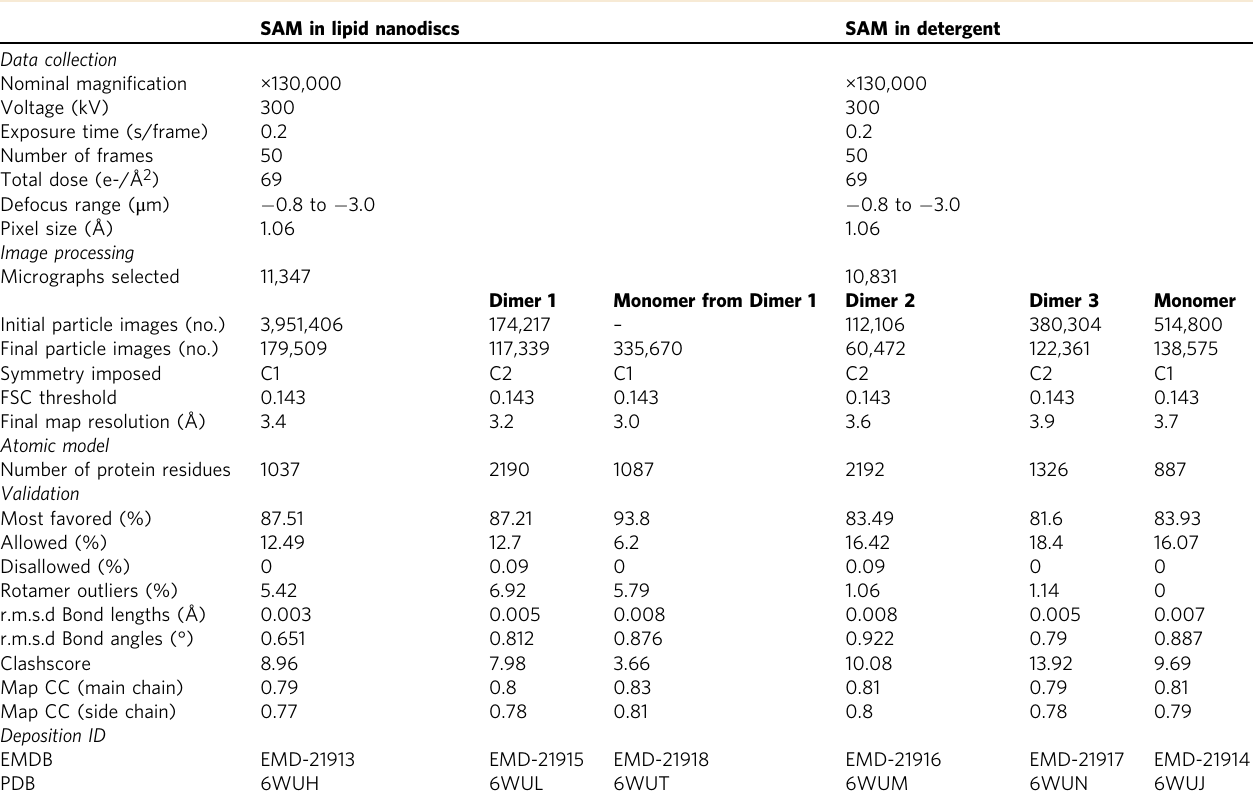
Table 1 CryoEM data collection, structure determination and model